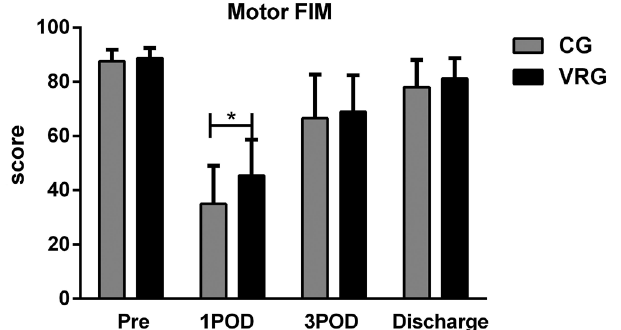
Fig. 3 – Effects of treatment on the cognitive FIM score in patients undergoing cardiac surgery. CG = Control Group; VRG = Virtual Reality Group; FIM = Functional Independence Measure, Pre = Pre operative; 1POD = first postoperative day; 3POD = third postoperative day; Discharge = Discharge day. Data were analyzed using two-way ANOVA. No differences were